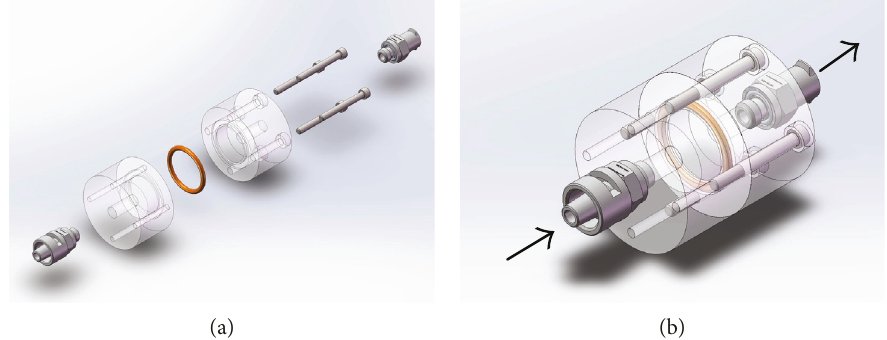
Figure 1: A scheme design of cellular infusion system. Two acrylic cylindrical paths allow pressurized perfusion of cell containing medium through a sca ff old that results in cell seeding of the various layers of the sca ff old. (a) Infusion system components. (b) Medium fl ow